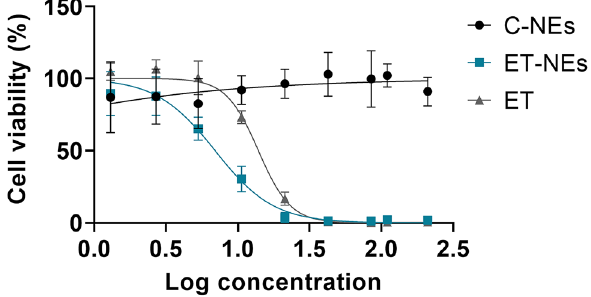
Figure 3. MDA-MB-231 cell viability upon the treatment with increasing concentrations of free edelfosine (ET) edelfosine nanoemulsions (ET-NEs) and control nanoemulsions (C-NEs) during 24 h at 37 °C.